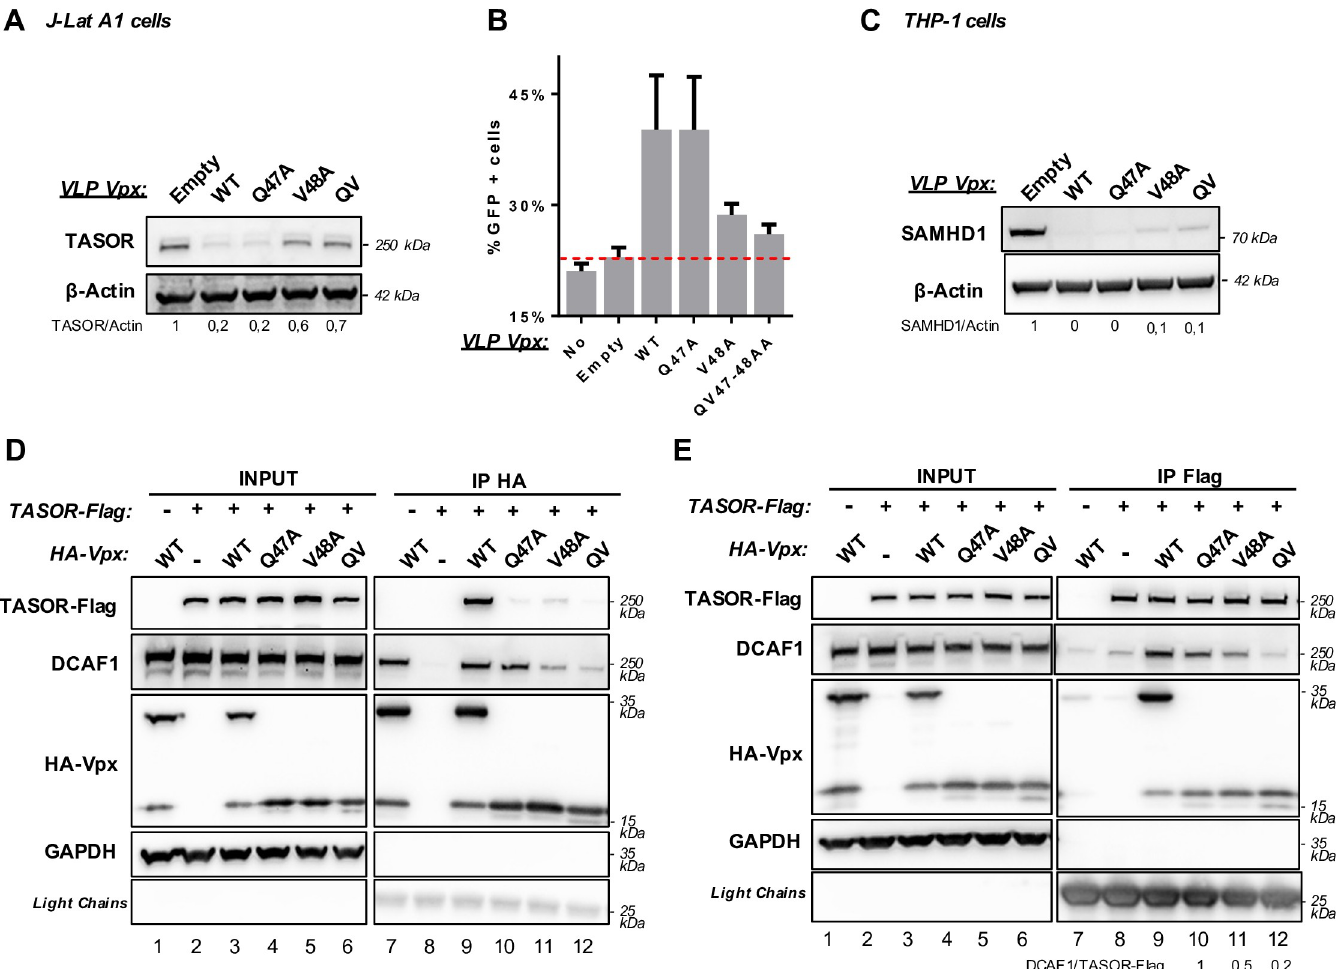
Fig 3. Vpx Q47AV48A loss of activity in J-Lat A1 T cells results from the V48A mutation. ( A and B ) HIV-2.Gh1 Vpx WT or indicated mutants were tested for TASOR degradation ( A ) and viral reactivation in J-Lat A1 T cells ( B ). J-Lat A1 T cells were treated with Vpx-containing VLPs. After overnight treatment with TNF- α , cells were analyzed by flow cytometry and whole-cell extracts by western blot. For each mutant, reactivation assay was performed at least 3 times and the immunoblot shown is representative of at least 3 independent VLP productions, SD is shown. ( C ) HIV-2.Gh1 Vpx WT or indicated mutants were tested for SAMDH1 degradation. Non-differentiated THP-1 cells were treated for 24h with VLPs and whole-cell extracts were analyzed by western blot. The shown immunoblot is representative of at least 3 independent VLP productions. Empty : VLP in which Vpx is not incorporated. QV : Vpx Q47A-V48A double mutant. ( D and E ) HA-Vpx WT or indicated mutants were co-expressed along with TASOR-Flag in HeLa cells, then an anti-HA ( D ) or anti-Flag ( E ) immunoprecipitation was performed. shown immunoblots are representative of 3 independent experiments.